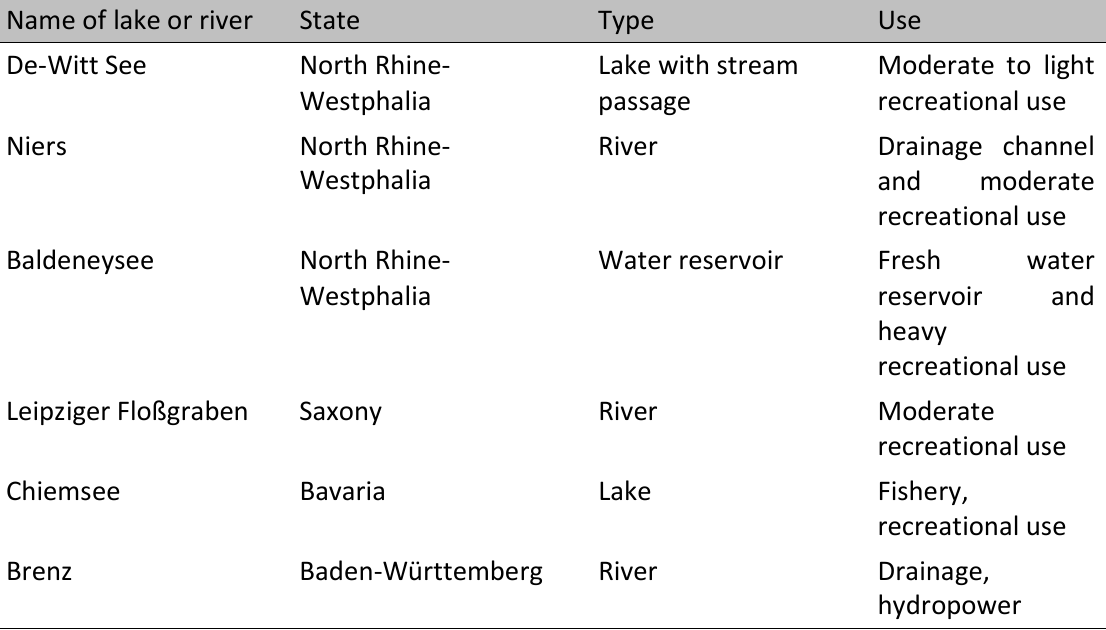
Table 1 Cases Selected for In-Depth